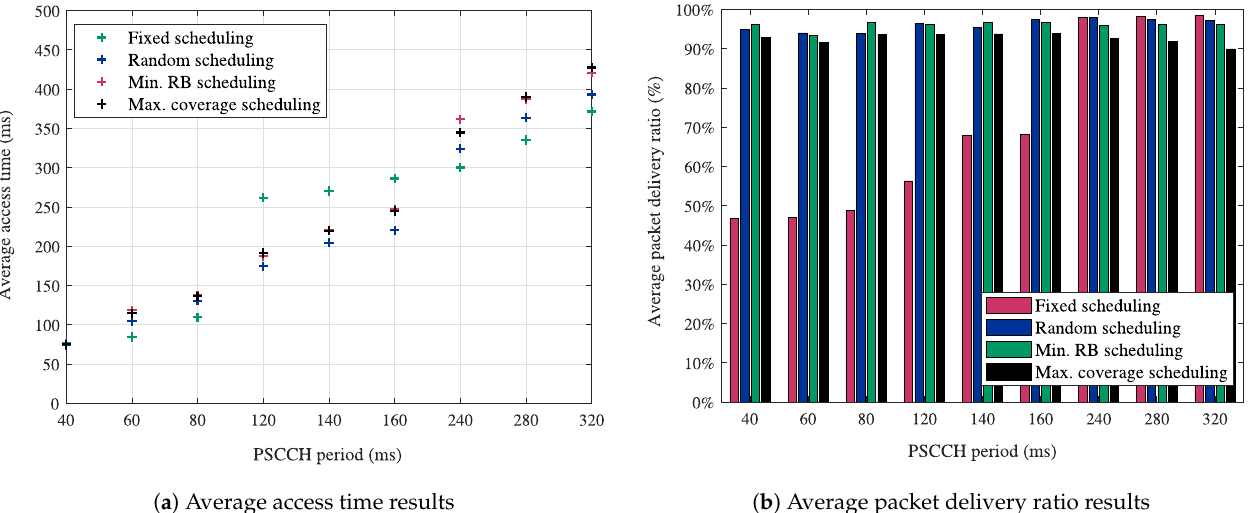
Figure 8. Impact of the resource selection methods in sidelink transmission mode-2 on latency and reliability performance in MCPTT private